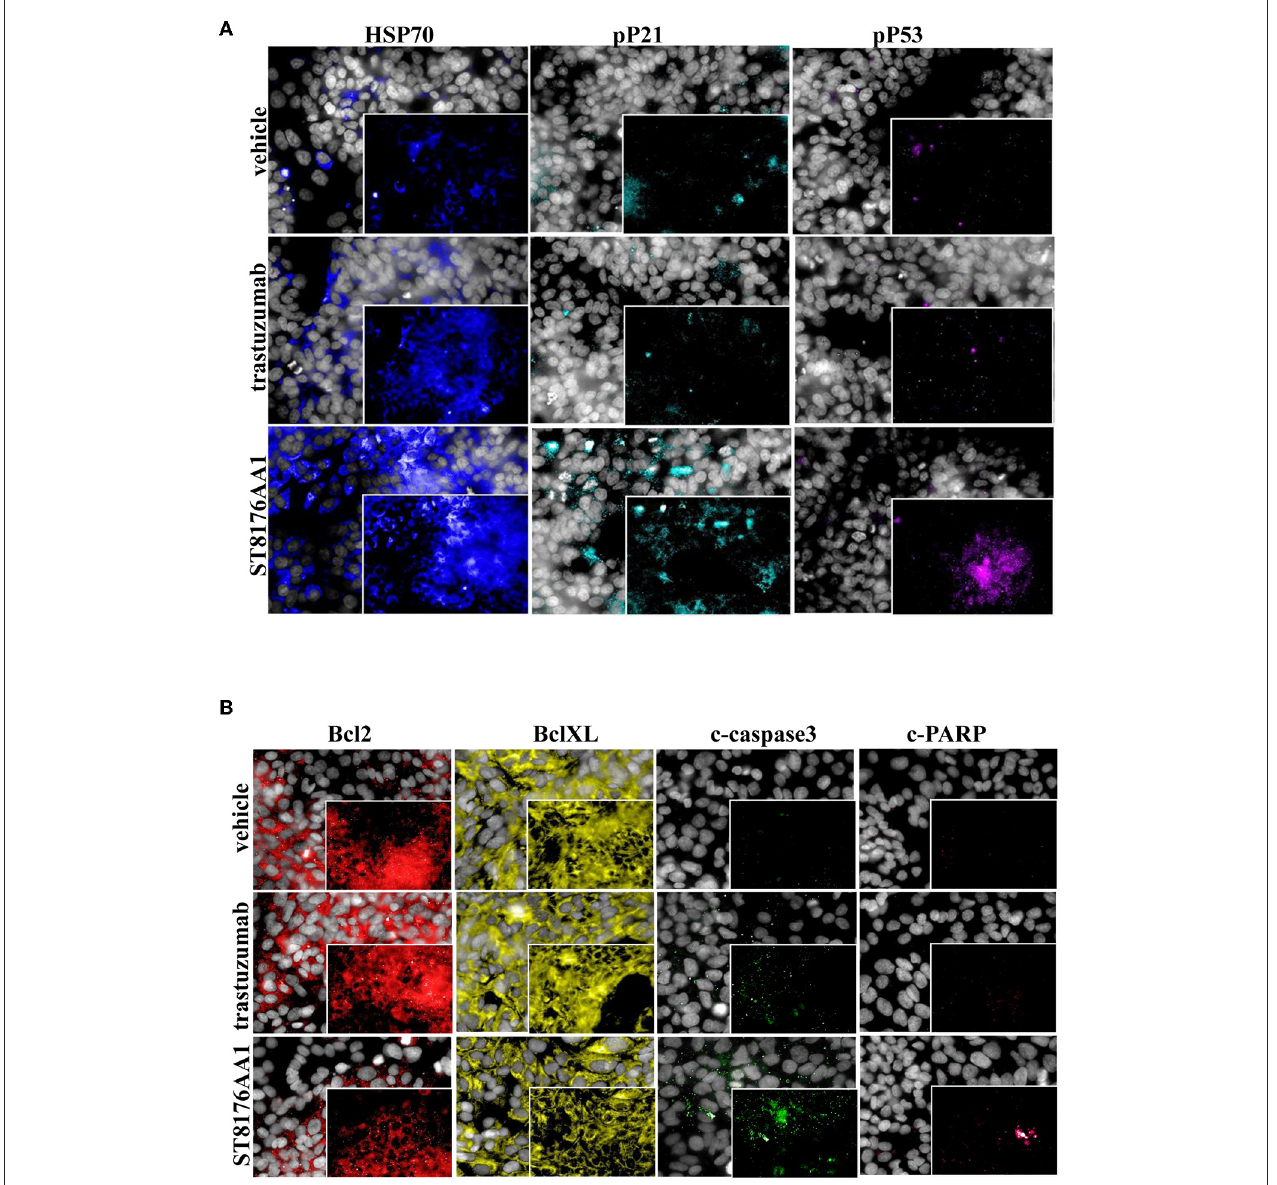
FIGURE 5 | ST8176AA1 induces cell damage and reduces apoptosis resistance in tumor cells. (A) HCS imaging analysis showing that LS174T cells treated with ST8176AA1 exhibit increased expression of damage markers HSP70, phospho-P21 (pP21) and phospho-P53 (pP53), compared to trastuzumab. ST8176AA1, and trastuzumab were used at 5 µ g/mL (3h incubation). (B) HCS imaging analysis showing that SKOV3 cells treated with ST8176AA1 exhibit reduced expression of the apoptosis resistance biomarkers Bcl2 and BclXL and increased pro-apoptotic cleaved-caspase3 and cleaved-PARP proteins, compared to trastuzumab. ST8176AA1 and trastuzumab were used at 40 µ g/mL (3 days incubation). In all panels, insets show specific fluorescence signals within the cells. Draq5 dye staining of nucleus (gray). Each image is representative of at least five fields of duplicate wells. Magnification 60X. Data are from one representative experiment out of two.